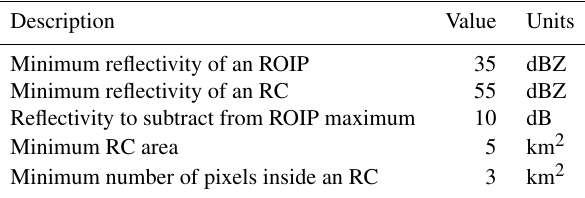
Table 1. Thresholds required in radar composites to identify poten- tial convective cells with the CCTA2D